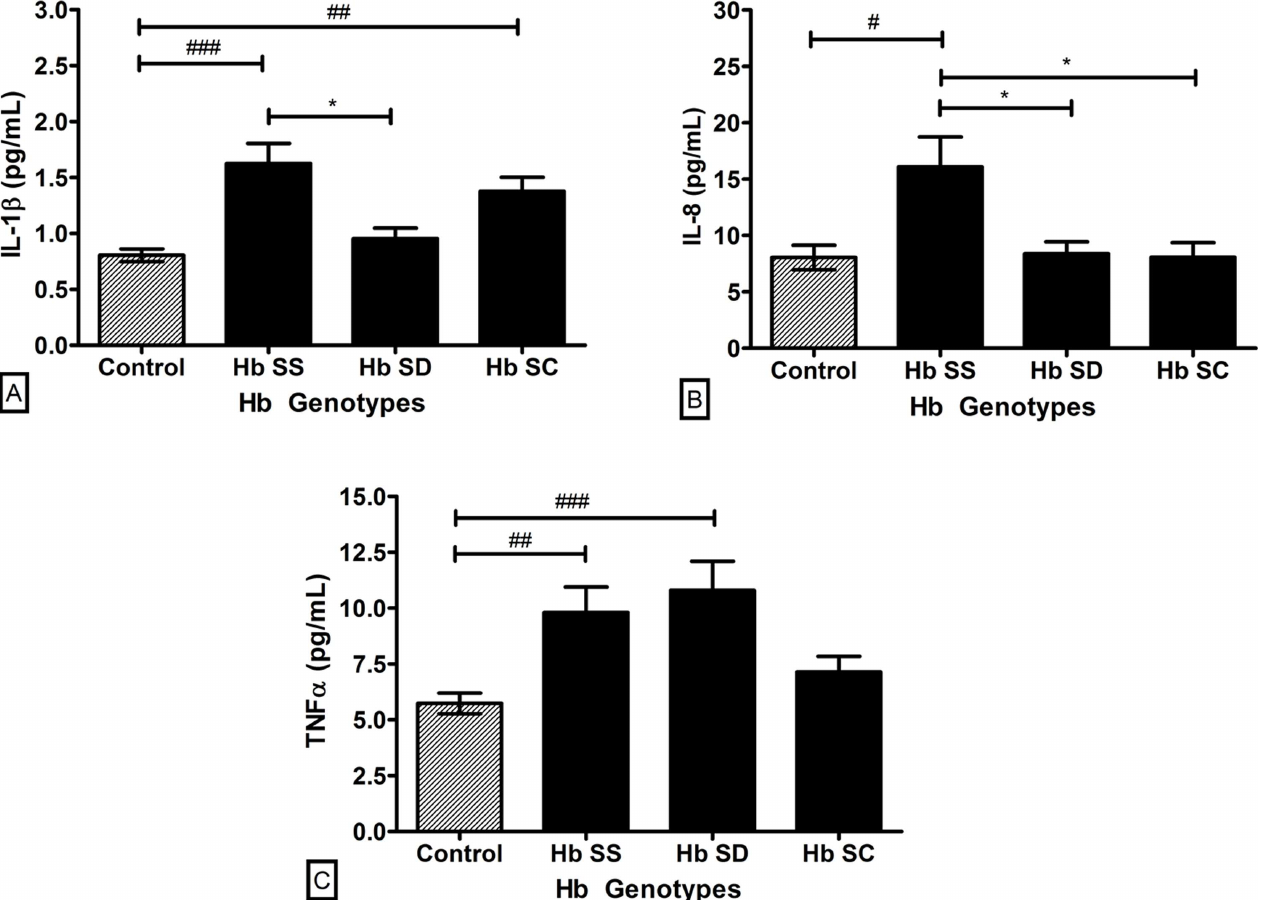
Fig 6. Plasma levels of the proinflammatory cytokines in the control group and SCD genotypes. (A) IL-1 β . (B) IL-8. (C) TNF- α . Data expressedin mean ± standard error of the mean. Statistical analysis: one-way ANOVA . * p < 0.05 for Tukey-Krumer post hoc . # Dunnett’s post hoc ( # p < 0.05. ## p < 0.01. ### p <